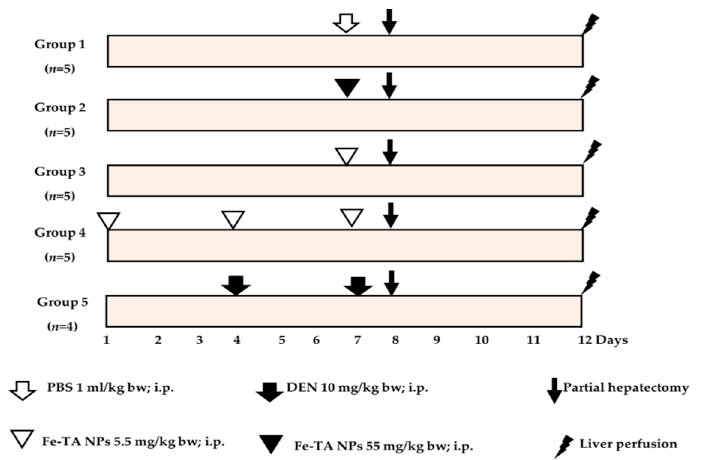
Figure 1. Experimental protocol for clastogenicity test of Fe-TA NPs in rats.